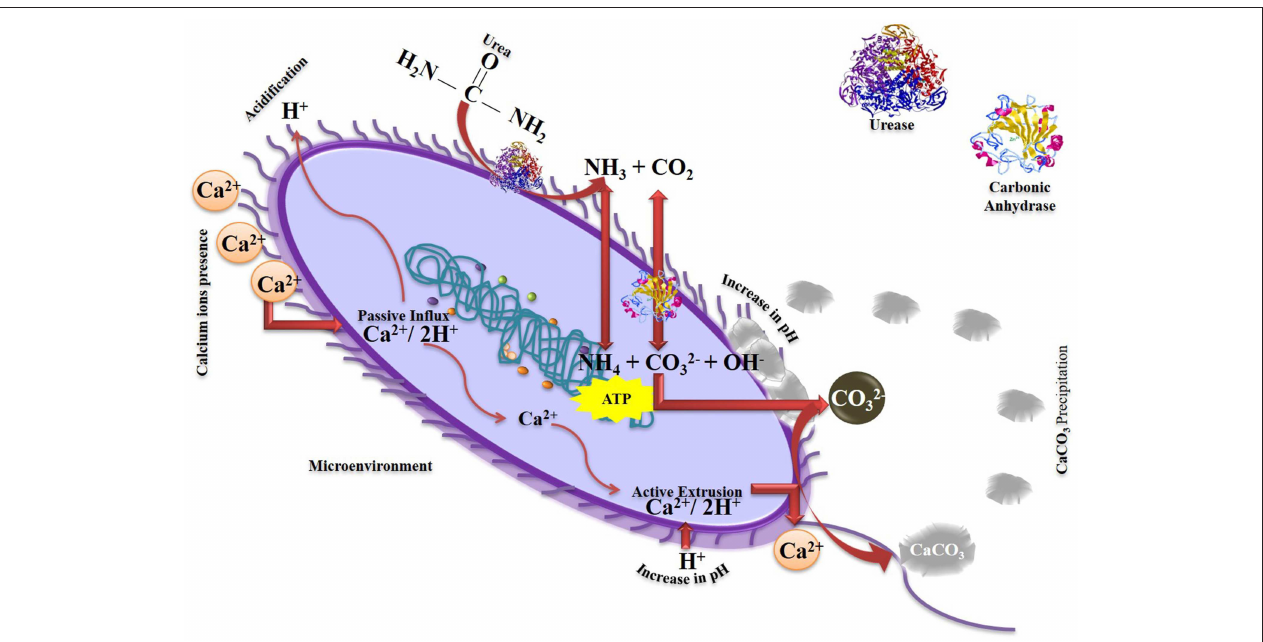
FIGURE 4 | Schematic diagram of MICP formation mediated by urease and carbonic